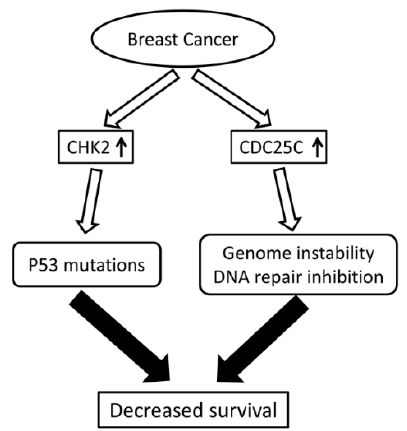
Figure 3. An overview of ATM/ATR-CDK2-CDC25C pathway in addition to the results of the study. Arrows inside the boxes indicate increased levels of CHK2 and CDC25C; all other arrows indicate “leading to”.